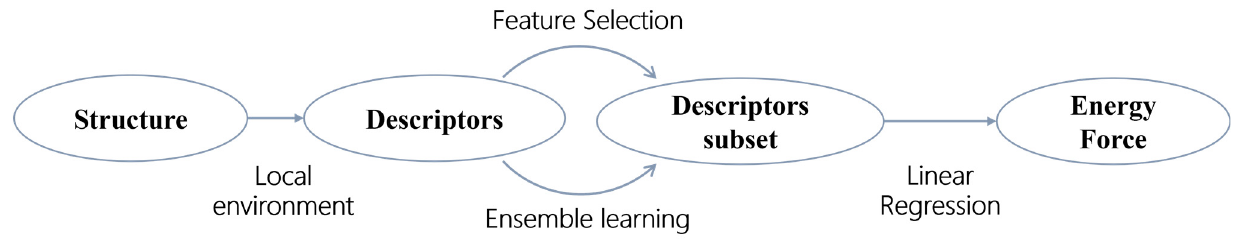
Figure 1. The mapping of EFS-qSNAP from crystal structure to its energy and